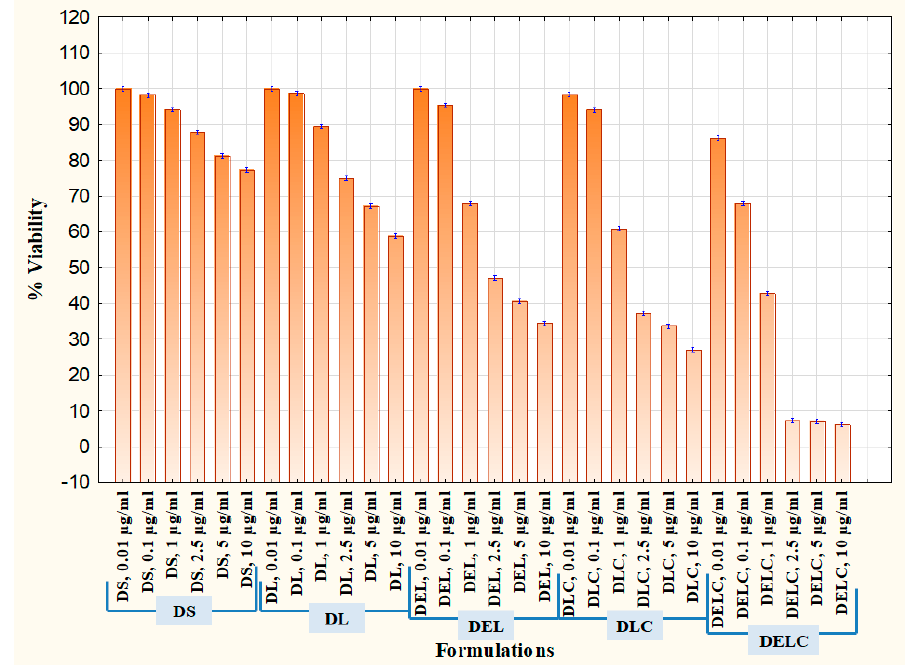
Figure 17. Proliferation Assay in EA.hy926 cells.